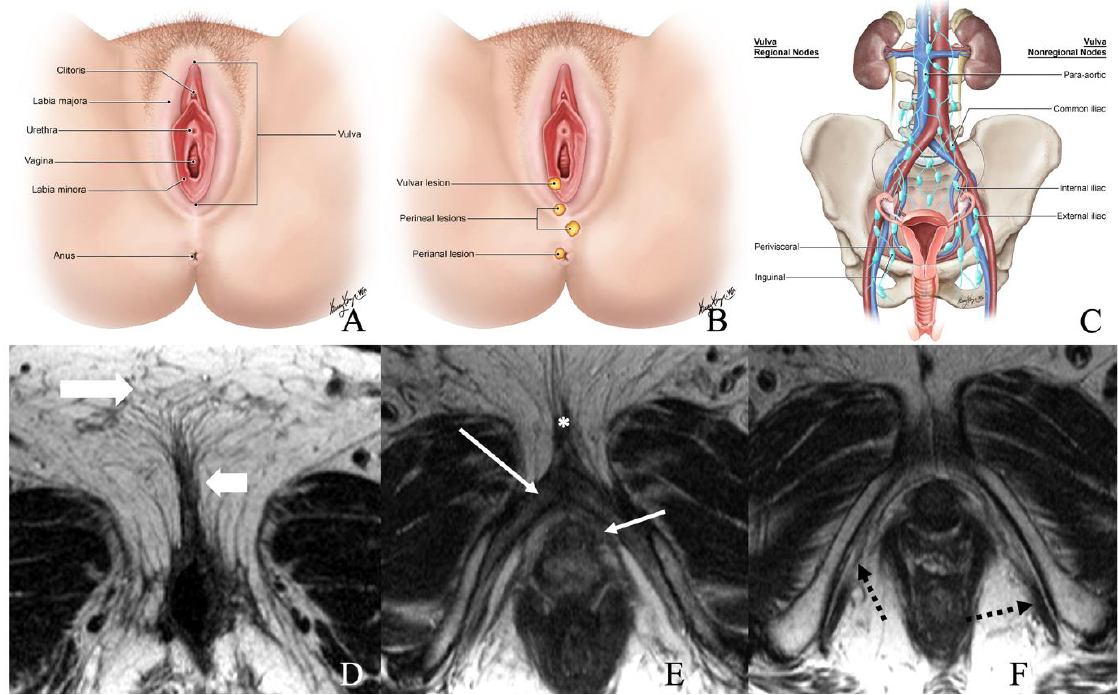
Figure 1. ( A ) Normal anatomy of vulvar region. ( B ) Normal description of location of lesions. ( C ) Regional and non-regional lymph nodes of the vulva. ( D – F ) Axial non-fat saturated T2-weighted images (WI) of a 36-year-old-female with normal anatomy. Image D demonstrates labia majora (long thick arrow) and labia minora (short, thin arrow). Image E shows the bulb of the vestibule (short, thin arrow), glans (asterisk), and crus (long thin arrow) of the clitoris. Image F demonstrates the ischiocavernosus muscle (dotted arrow).